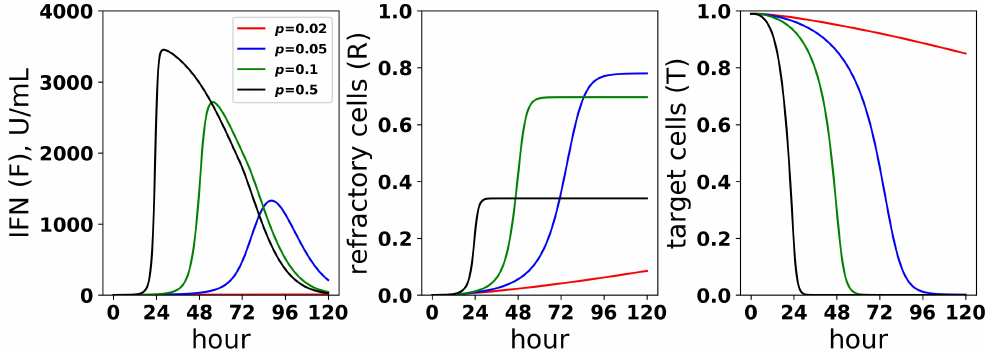
Figure 10. Dynamics of the IFN positive feedback loop. Infection dynamics are shown for different infectivity rates p ; see the legend. For each p , a pulsed secretion rate model was assumed. For p = 0.05,0.1,0.5, the feedback loop activates, leading to a rise in extracellular IFN concentrations (F) and a concordant transformation of target cells (T) into refractory cells (R) and the end of infection. For p = 0.01, the feedback loop does not activate. Dynamics were simulated using a pulsed secretion rate model with q 0 = 0.01, q 1 = 1, and ¯ F =